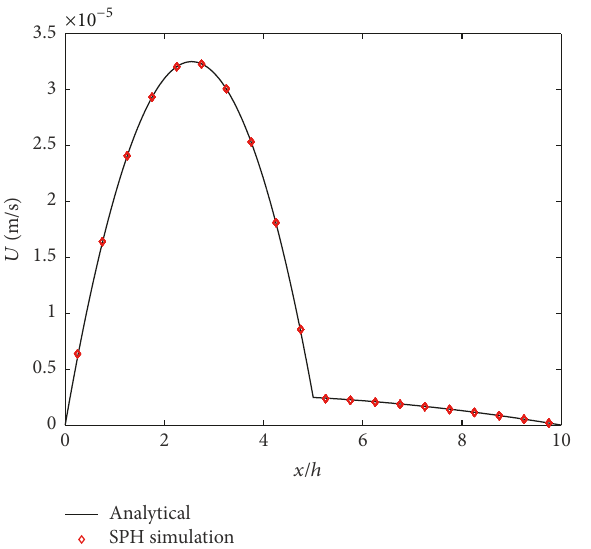
Figure 6: Elastic cube volume change due to applied fluid